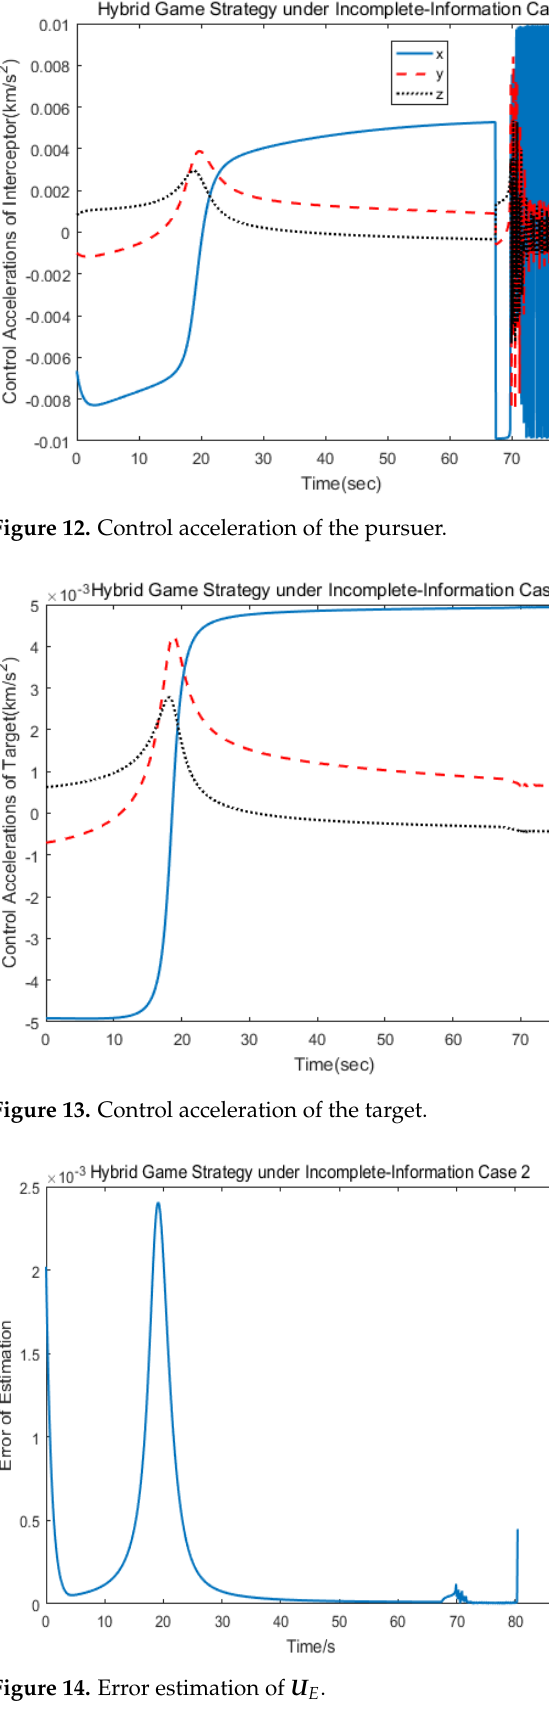
Figure 11. Relative distance between the pursuer and the target.